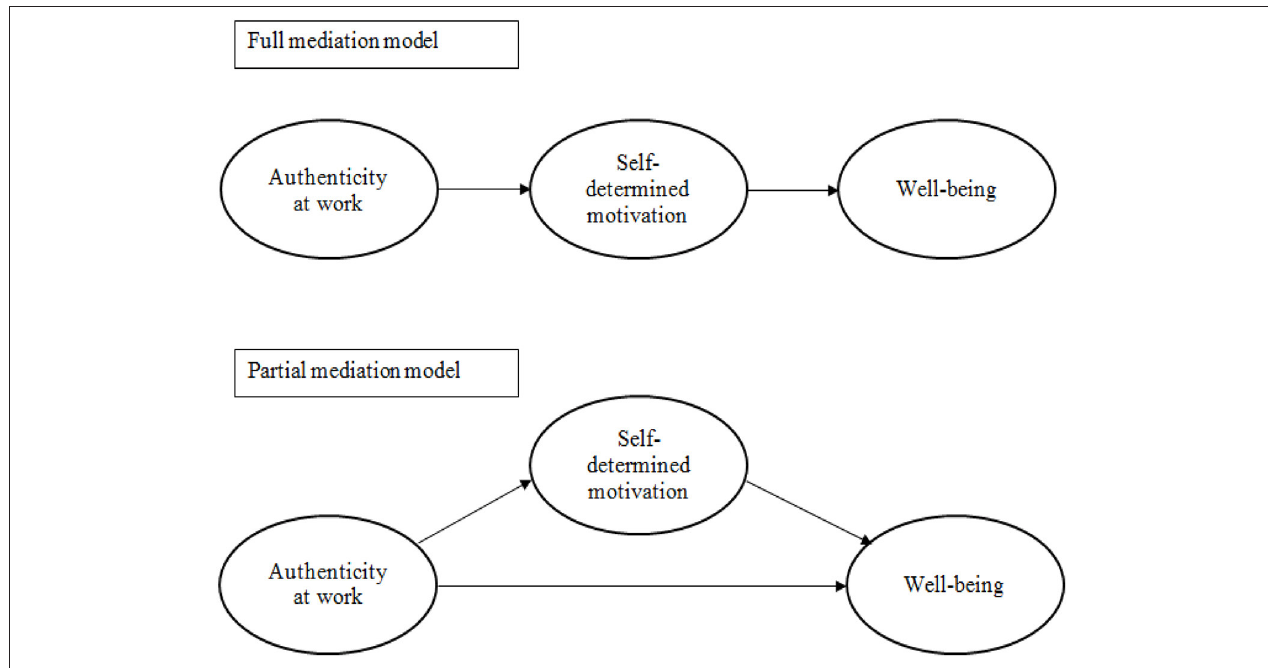
FIGURE 1 | Heuristic model of the full and partial mediation model between authenticity at work, self-determined motivation, and